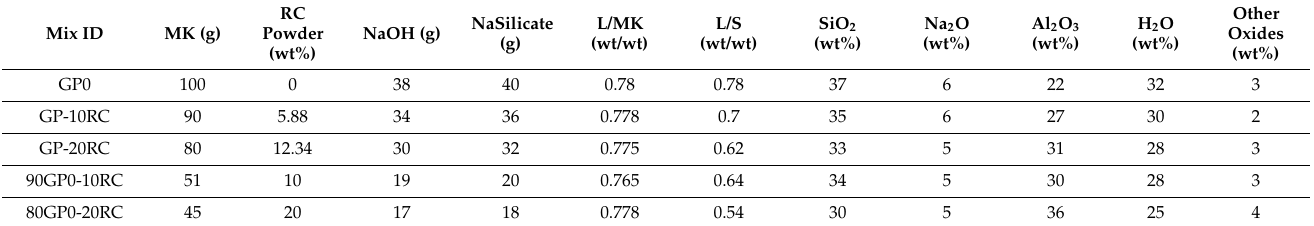
Table 1. Mix design of mortar formulations containing various amounts of RC. L/S indicates the liquid to solid wt/wt ratio, where liquid has to be the intended 8 M NaOH plus sodium silicate solution. L/MK wt/wt ratio indicates the liquid to MK wt/wt ratio, where L = NaOH + NaSilicate (See text for more